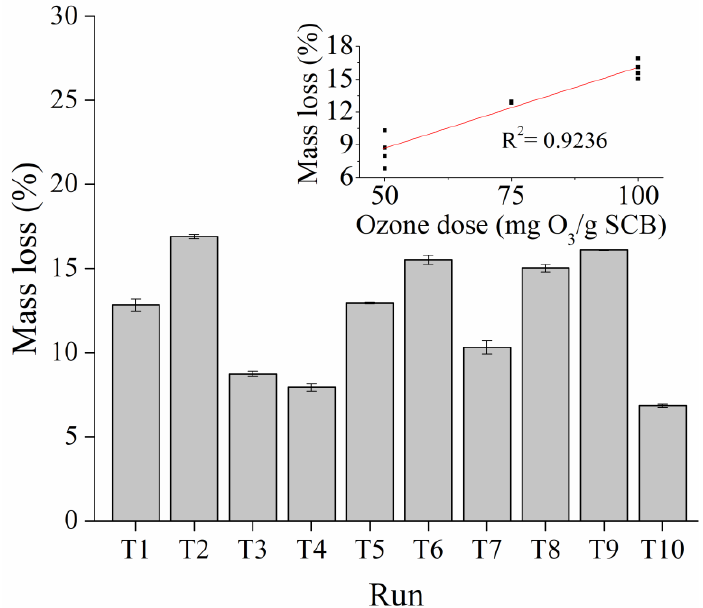
Figure 2. Mass loss of sugarcane bagasse (SCB) after the application of ozone pretreatment in different experimental conditions (inset figure shows the loss of mass at the different applied ozone doses).